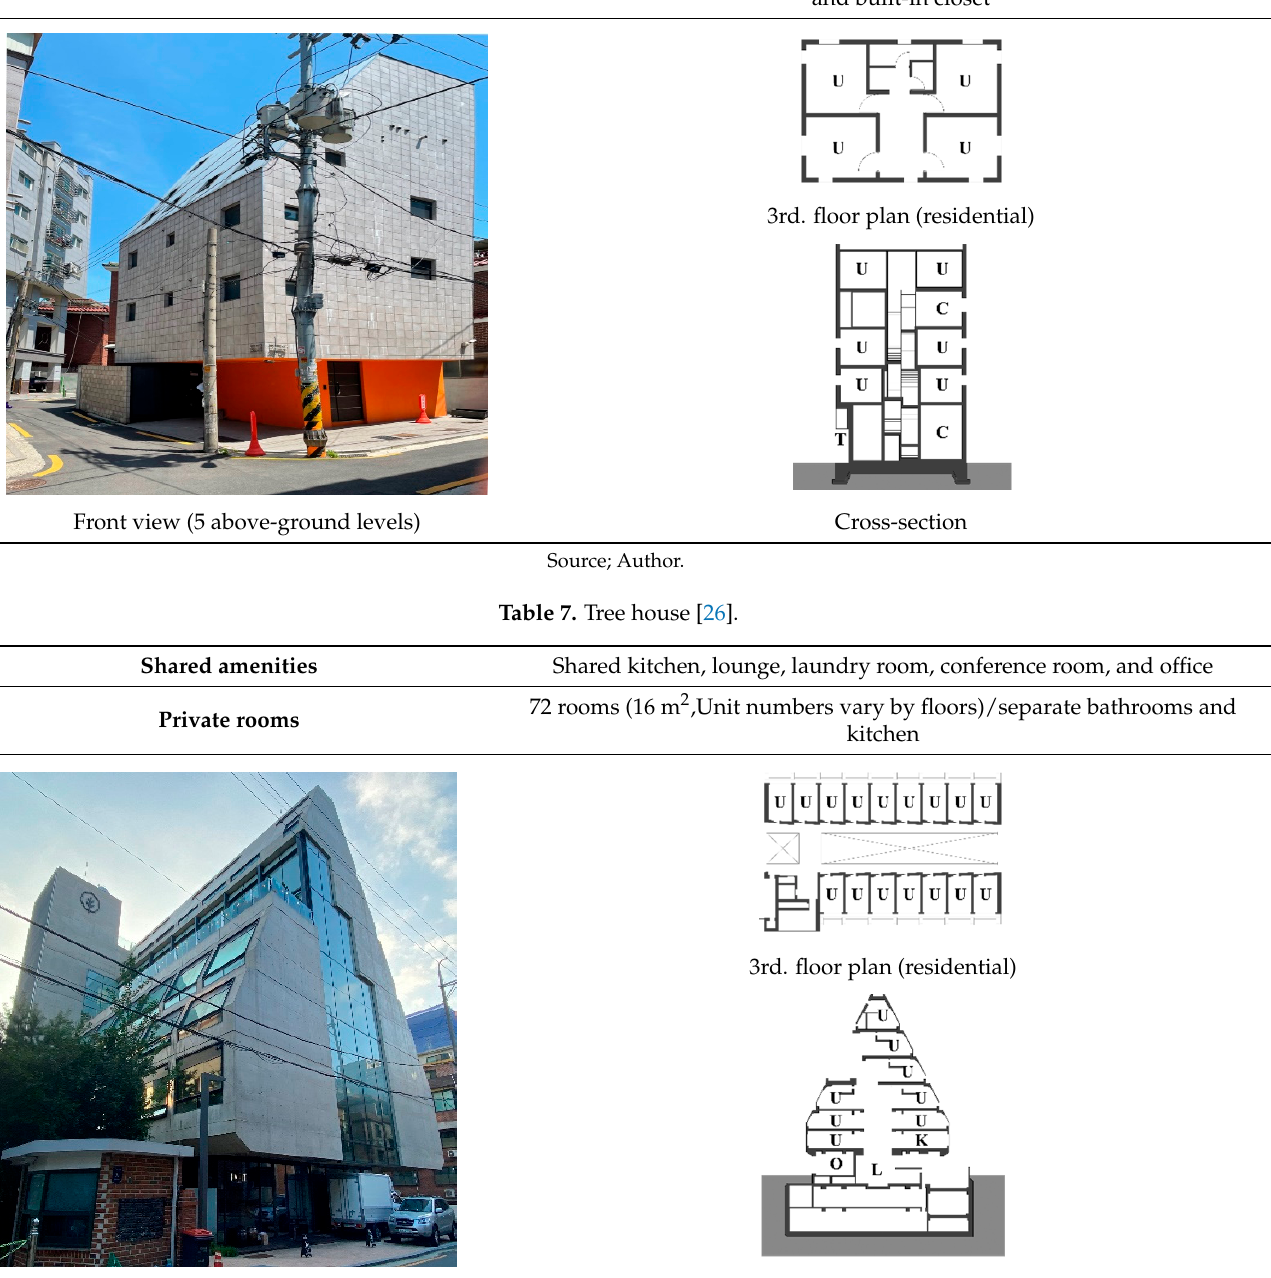
Table 7. Tree house [26].